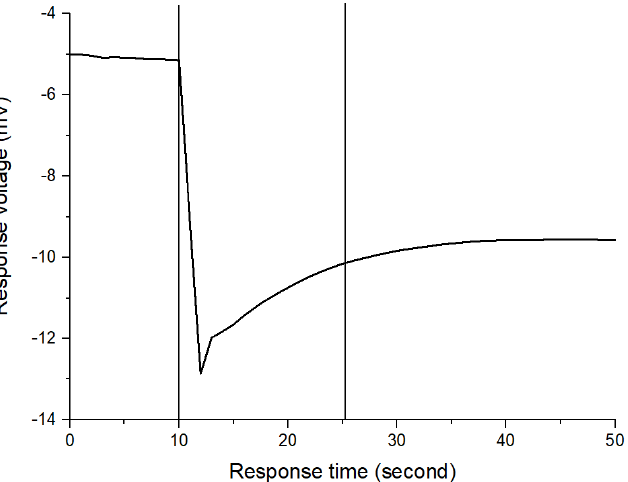
Figure 9. The curves of response time for flexible lactate biosensor based on FePt NPs/CZO sensing films.